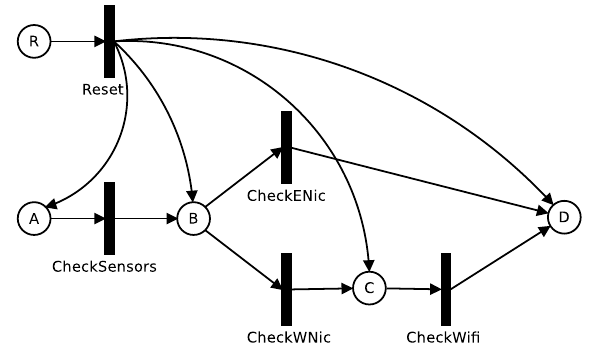
Figure 3: Graphical representation of the state variables and actions that represent the paths of the example model seen in Figure 1. The state variables and actions for component failure and repair have been omitted for clarity. Arcs repre- sent preconditions and effects of an action.